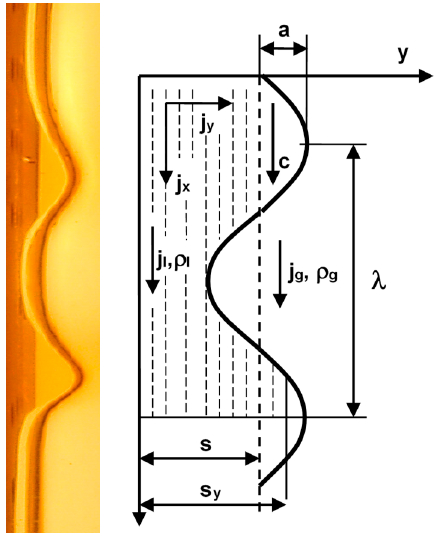
Figure 4. Determination of quantities characterizing wavy flow of the liquid film.